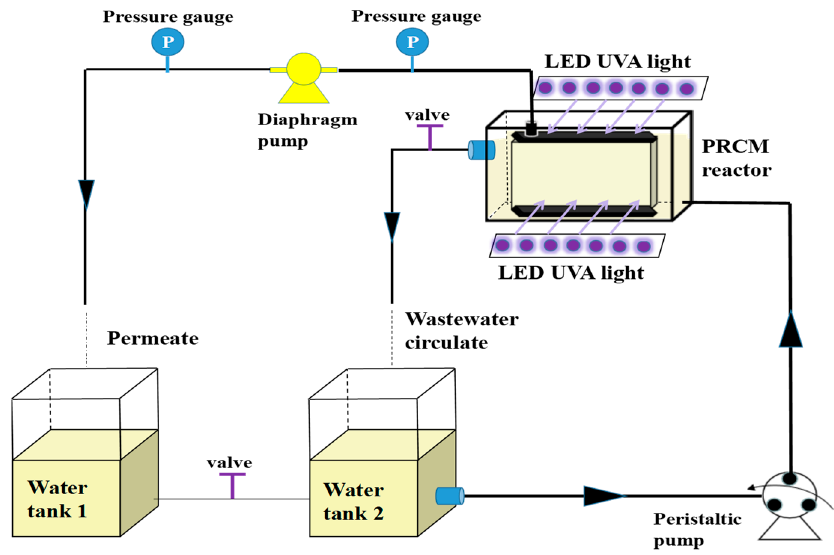
Figure 2. Diagram of fi xed bed reactor and experimental setup of the PRCM.